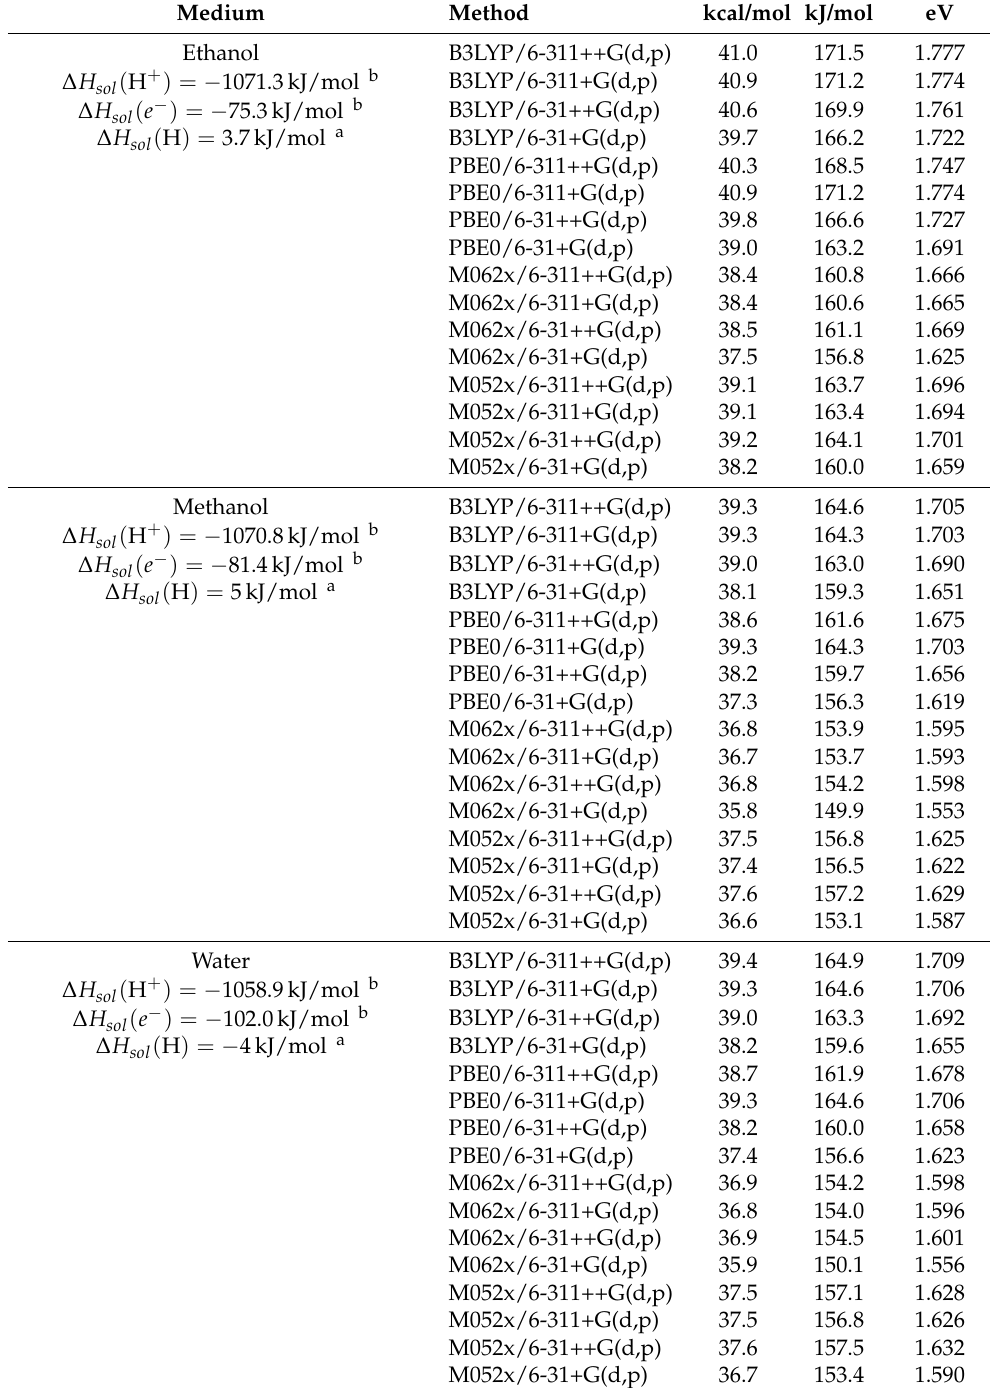
a Cf. Table 3, [54]. b Cf. Table 5,